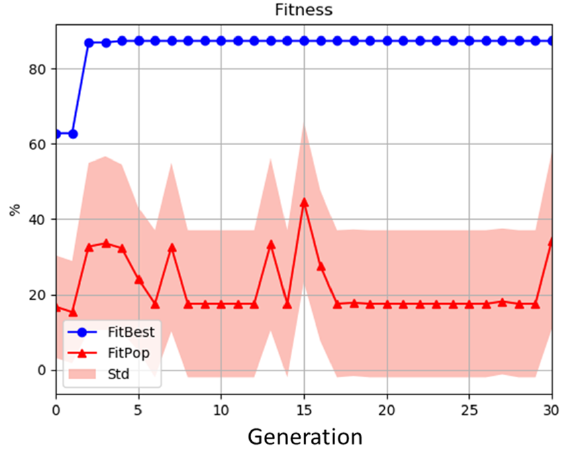
Figure 12. Fitness convergence.